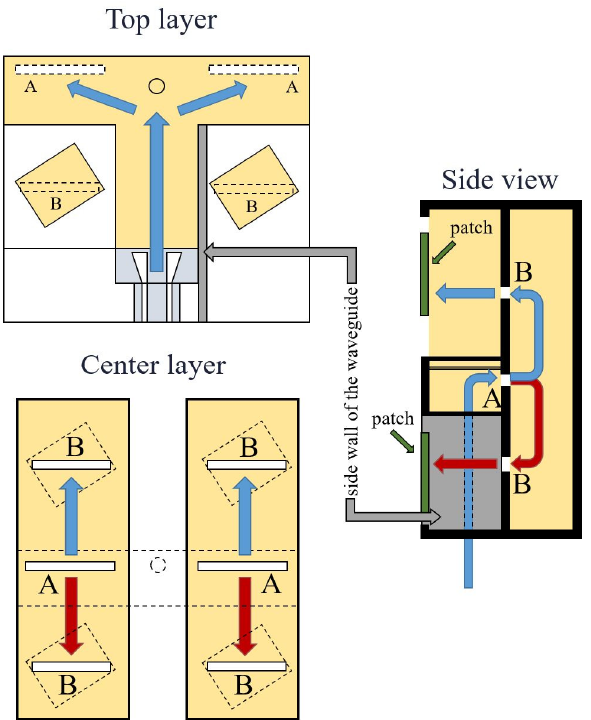
Figure 1. Concept of a two-layer 2 × 2 antenna array fed by substrate-integrated waveguides. Input power from grounded coplanar waveguide enters the top substrate via slots A and, through the bottom substrate, excites patches via apertures